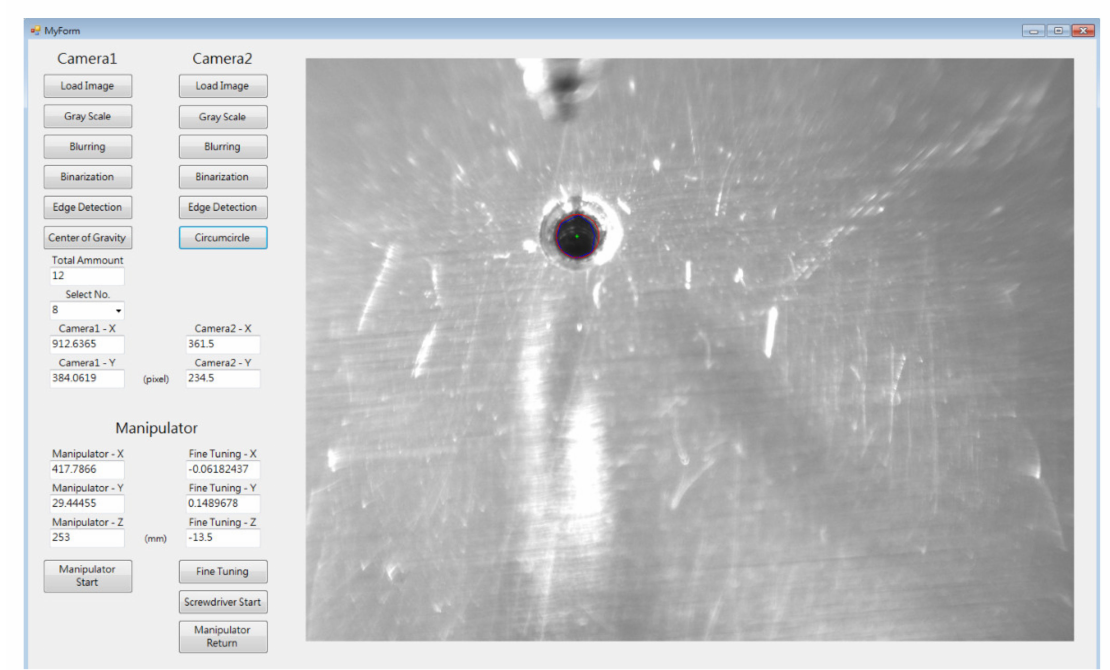
Figure 10. A photograph is captured using Camera 2, and the image is processed on the HMI.